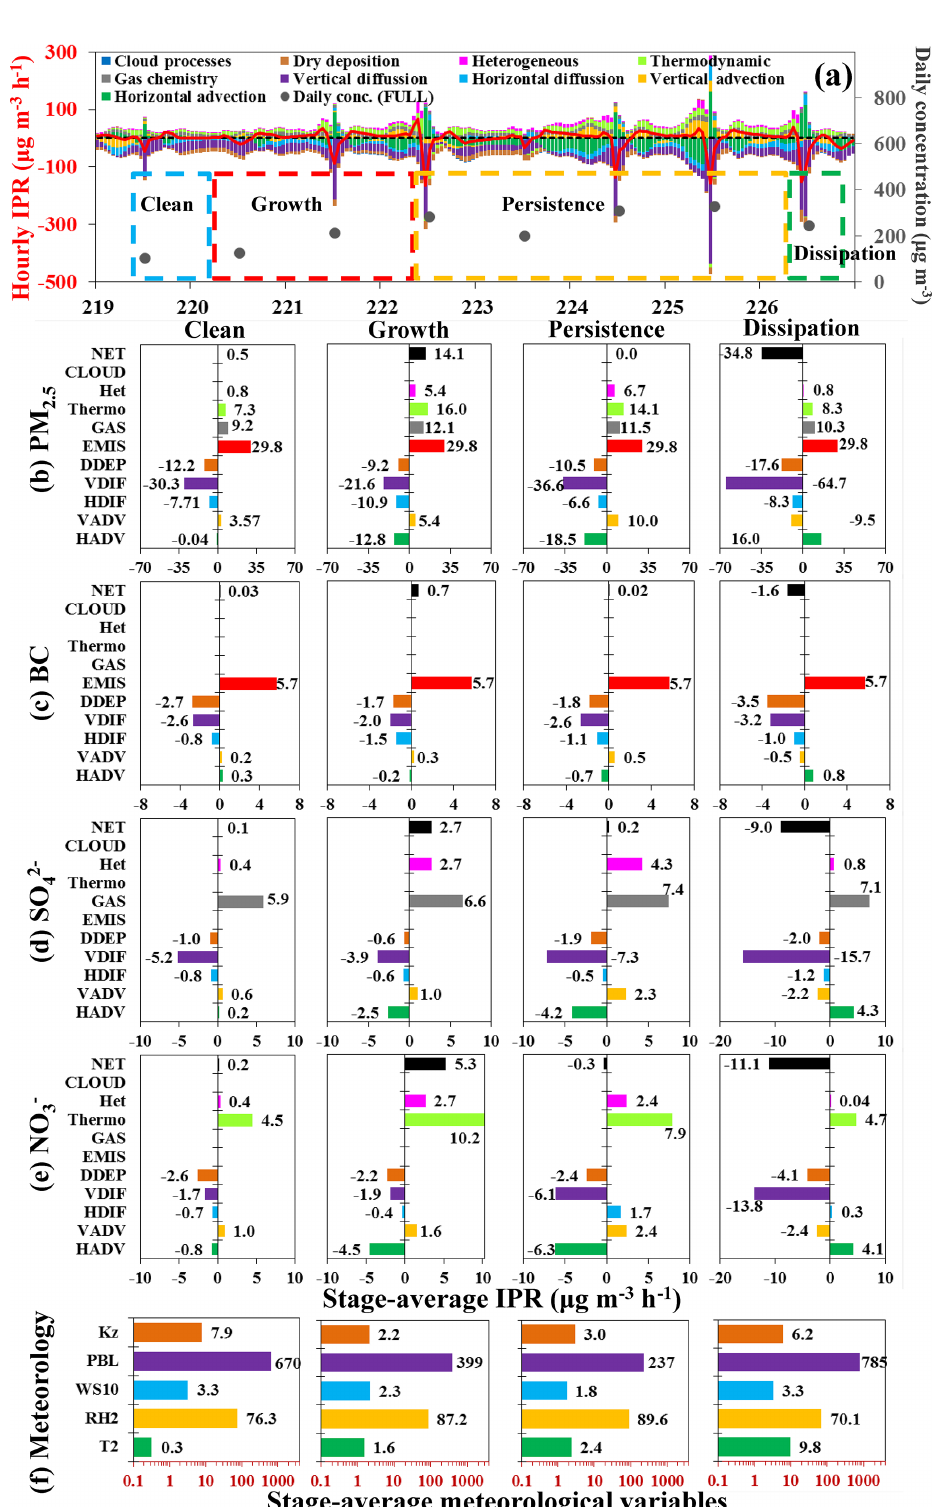
Figure 8. The model-calculated integrated process rates (IPRs) for the first haze episode (20–26 February) in Beijing. (a) Hourly IPR, daily PM 2 . 5 concentration, and the division of the four stages. The nearly constant IPRs of emissions are not shown for clarity. The mean IPRs for (b) PM 2 . 5 , (c) BC, (d) sulfate (SO 2 − ), (e) nitrate (NO − ), and (f) mean meteorological variables are in the four stages. Note that zero IPR 4 3 values are not listed. (Units of T2, RH2, WS10, PBL, and K z are ◦ C, %, ms − 1 , m, and m 2 s − 1 ,